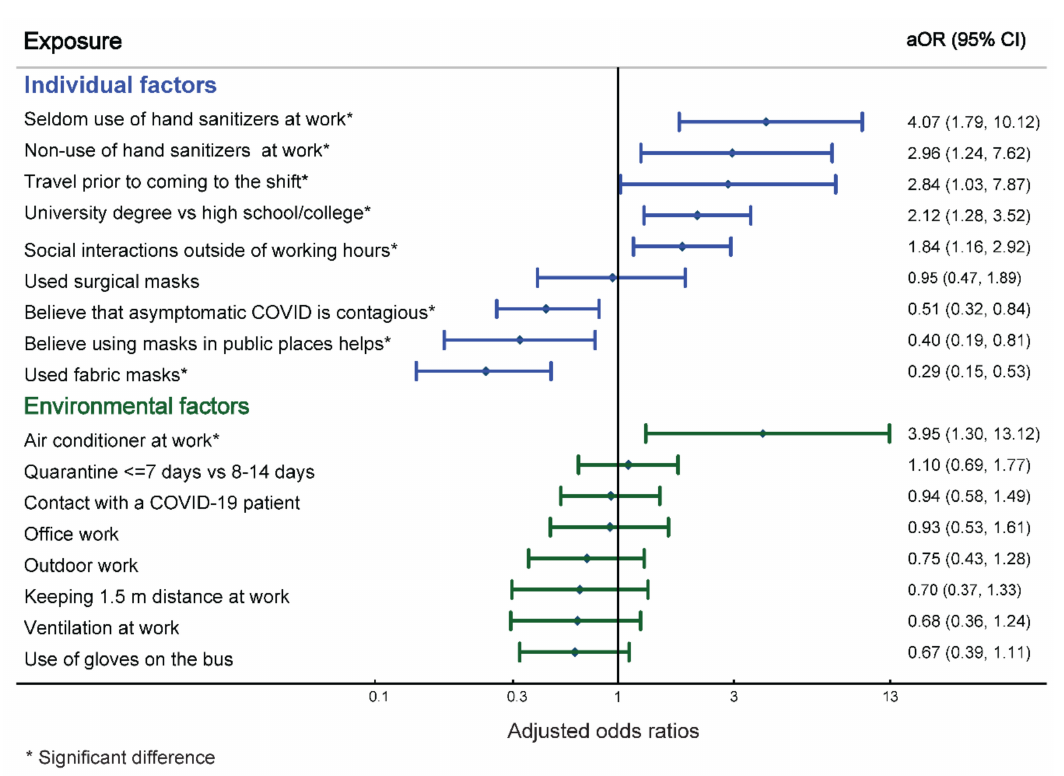
Figure 2. Adjusted odds ratios (aOR) and 95% confidence intervals (CI) for factors associated with the development of the COVID-19 disease in the employees of Tengizchevroil, Kazakhstan